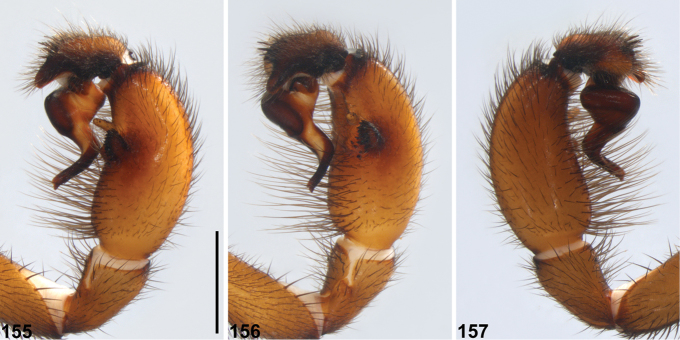

Idiosoma
formosum sp. n., male holotype (WAM T139470) from Mount Gibson Station (Western Australia; AVW), pedipalp. 155 Retrolateral view 156 Retroventral view 157 Prolateral view. Note that the tip of the embolus has broken off this specimen. Scale bar 2.0.